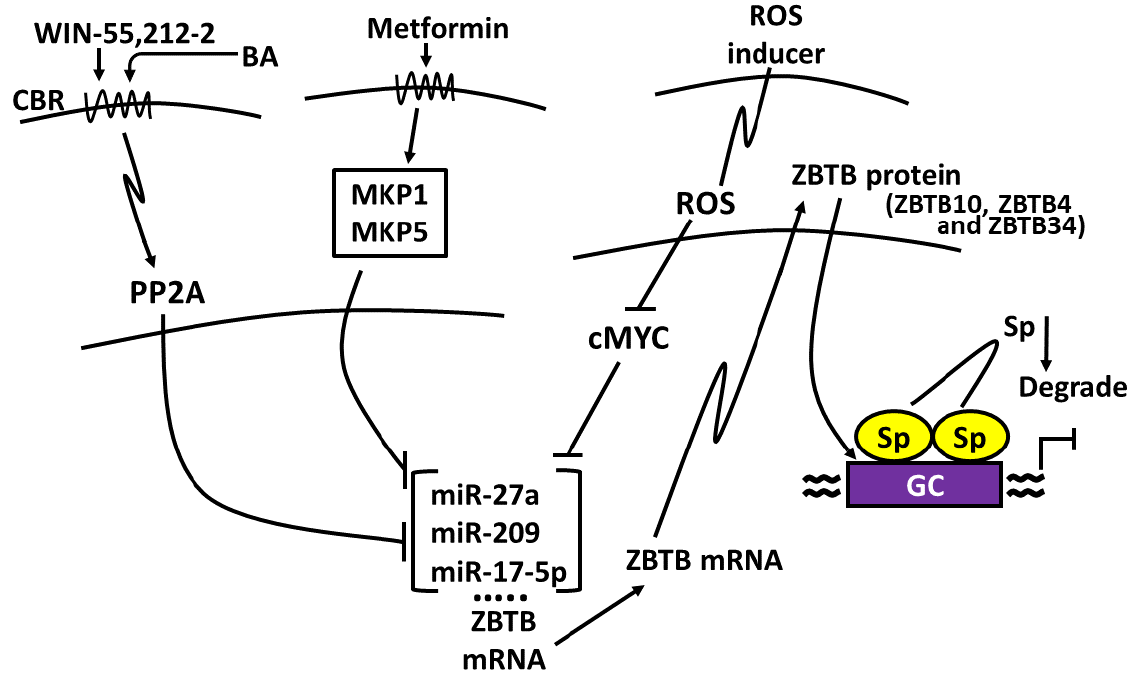
Figure 5. Mechanisms of Sp downregulation [149,150,160,162,164]: ROS-inducers target Myc [149,150] whereas Metformin and WIN target kinases [189 – 191] to activate ZBTB (via miRNA down- regulation), which displace Sp TFs from GC-rich sites. ZBTB genes induced via these pathways in- clude ZBTB10, ZBTB34 and